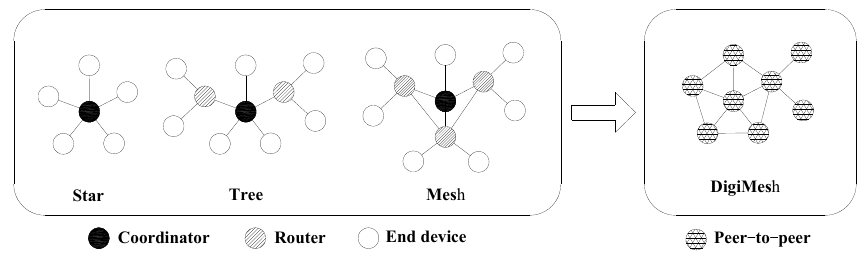
Figure 10. Comparison with different topology of the wireless sensor network.